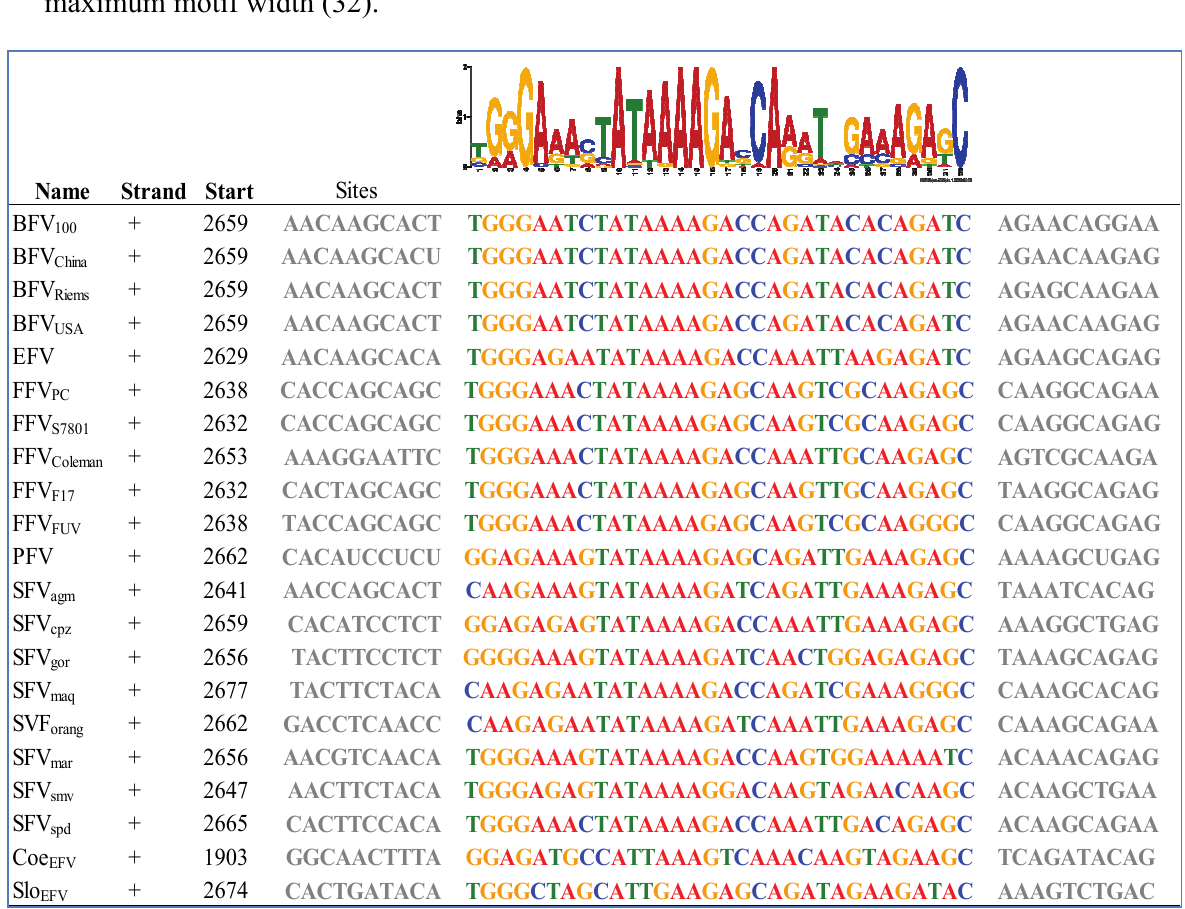
Figure 4. Bioinformatics-based detection of the IP TATA box and flanking sequences in exogenous and ancient endogenous FVs using the MEME (Multiple EM for Motif Elicidation) software [53]: The results obtained by MEME are displayed in a consensus sequence logo Figure on top of the individual sequences of the analyzed FVs (see Table